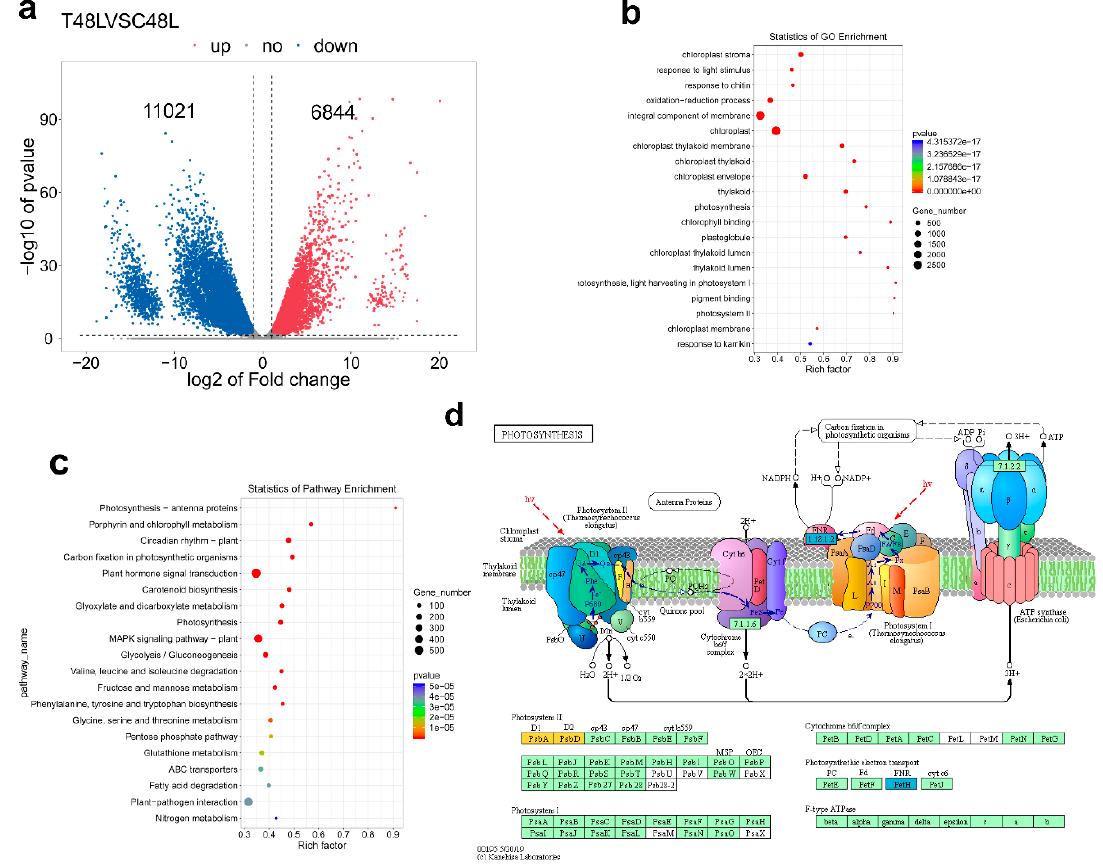
Figure 6. Function annotation of cotton di ff erentially expressed genes (DEGs). ( a ) Venn diagram shows DEGs. Blue and red colors indicate down- and upregulated genes, respectively. ( b ) Gene ontology (GO) classification of the assembled cotton genes (Top 20 enrichment GO term). The colors represent the p -value level and the value gradually increases from blue to red. The solid circle size means the number of DEGs. The rich factor is bigger, the enrichment degree is higher. ( c ) Kyoto Encyclopaedia of Genes and Genomes (KEGG) pathway analyses (Top 20 enrichment KEGG pathway). The colors represent the p -value level and the value gradually increases from blue to red. The solid circle size means the number of DEGs. The rich factor is bigger, and the enrichment degree is correspondingly higher. ( d ) Photosynthesis related gene down-regulate induced by TDZ. Red and blue represent the significantly up- and downregulated transcription of notes to a KO node, respectively; orange represents the significantly both upregulated and downregulated transcription of notes to a ko node.